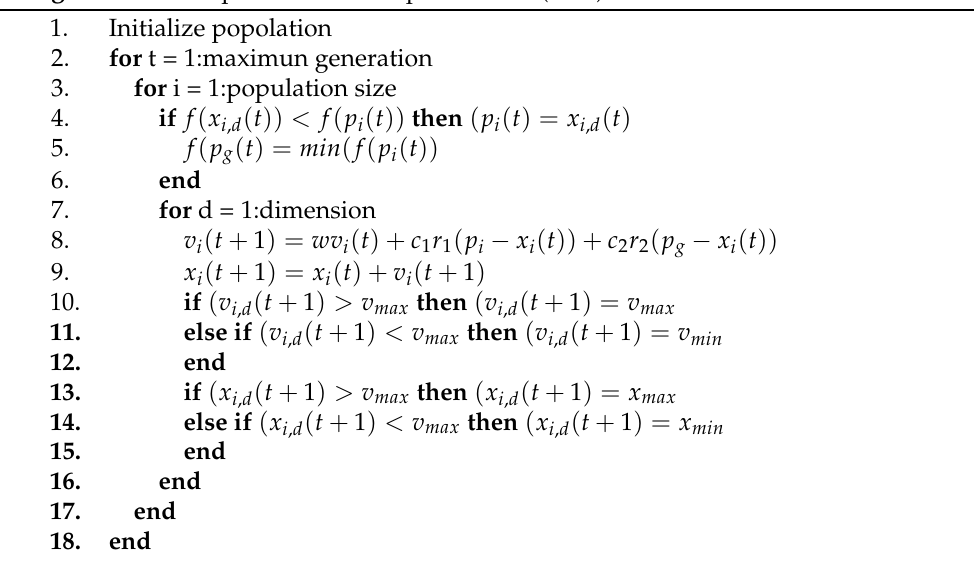
Figure 5. The algorithm flow chart of FNT. Algorithm 1: The particle swarm optimization